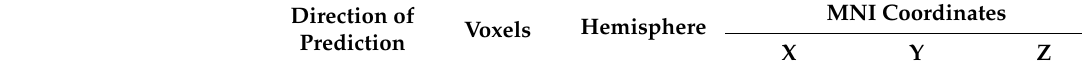
Voxels Hemisphere